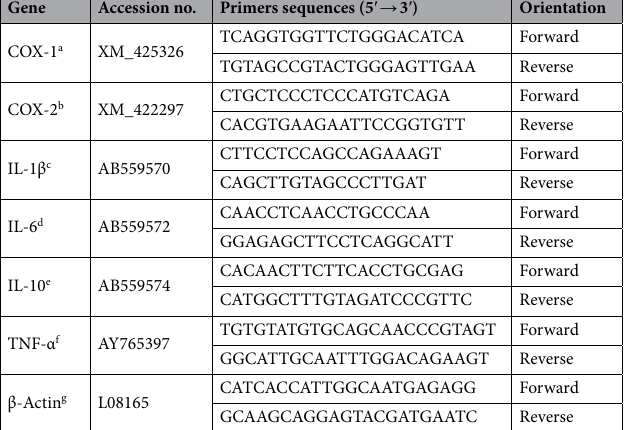
Table 3. Chicken primers used for real-time PCR. a Cyclooxygenases-1. b Cyclooxygenases-2. c Interleukin-1β. d Interleukin-6. e Interleukin-10. f Tumor necrosis factor-α. g COX-1, COX-2, IL-1β, IL-6, IL-10, and TNF-α mRNA data that are normalized by